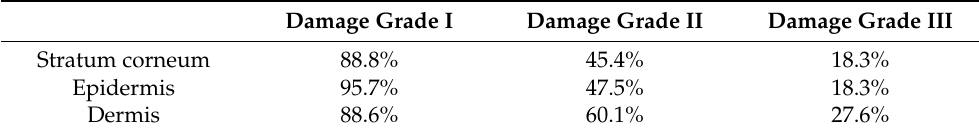
Table 1. Q-Health index values of the samples shown in Figure 4(b1–b3, c1–c3, and